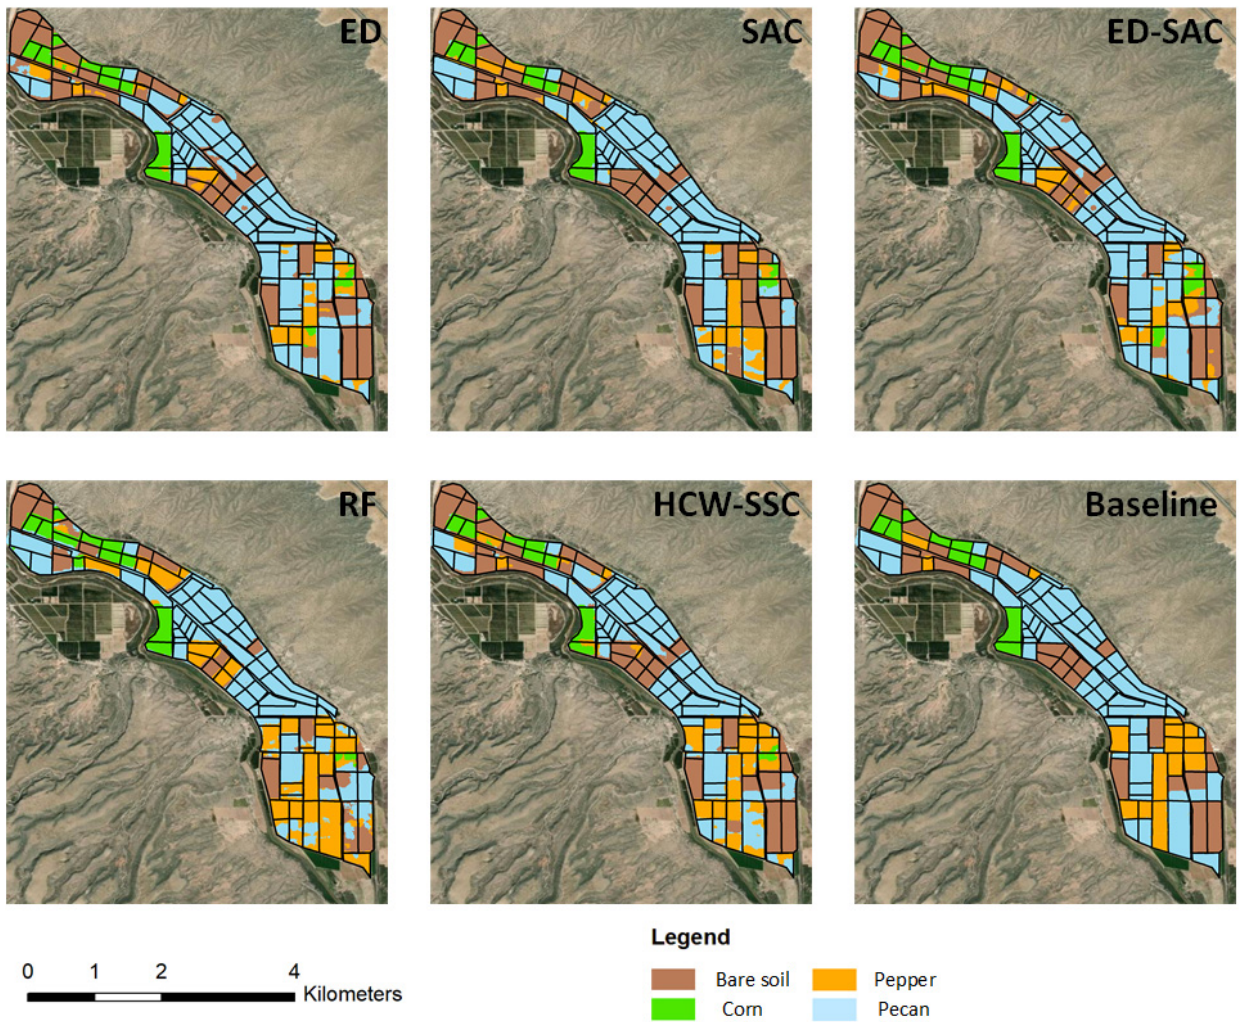
Figure 7. Classification maps of five different classification methods and baseline map (Euclidean distance (ED), spectral angle cosine (SAC), Euclidean distance–spectral angle cosine (ED-SAC), random forest (RF), and a new hybrid changing-weight classification method with a filter feature selection (HCW-SSC)).